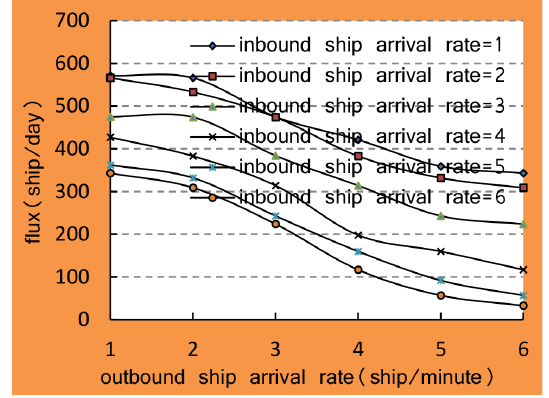
Figure 10. Traffic flux of waterway system and outbound ship arrival rate as a function at variable inbound ship arrival rate (when allow changing)